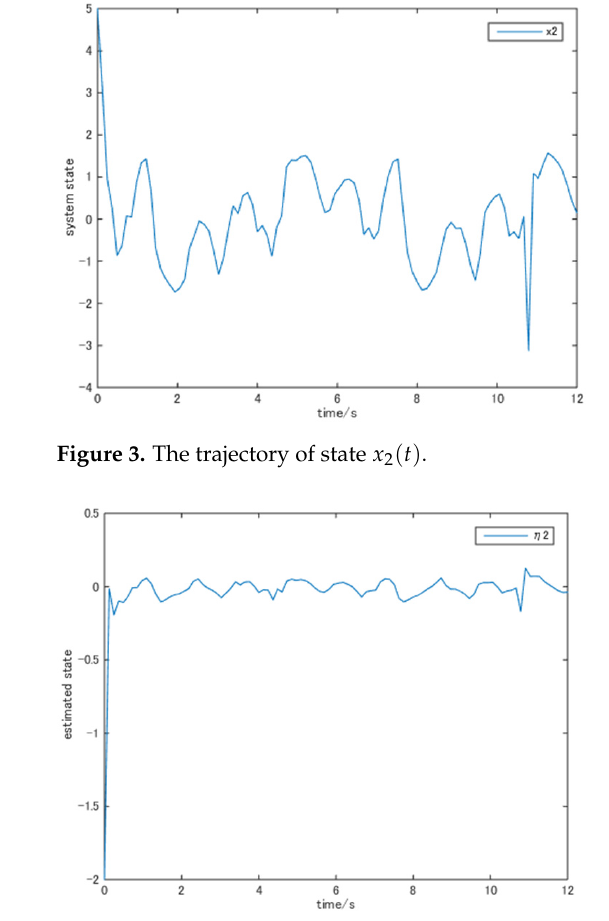
( t ) ( ) t η . Figure 4. The trajectory of state η 2 2